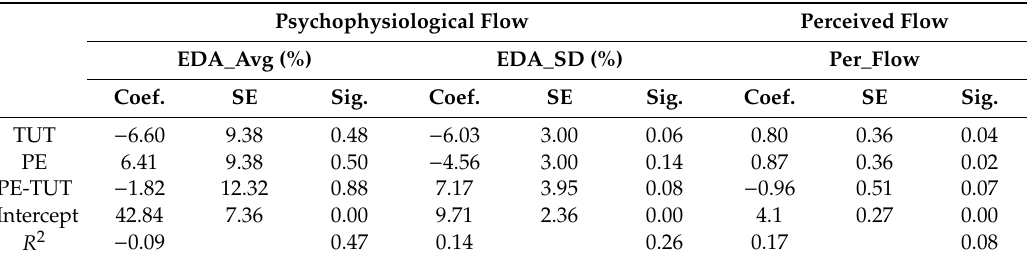
Table 1. Experimental condition e ff ect on flow.